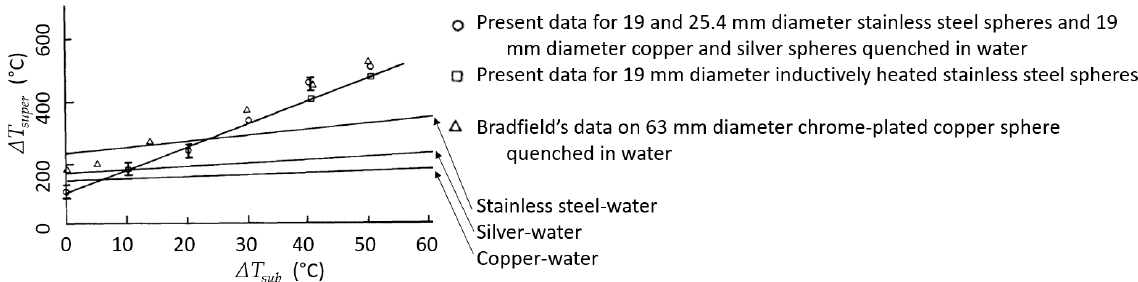
Figure 15. Minimum film boiling temperature for a combination of coolant subcooling ( ∆ T sub , X-axis) and hot sphere superheating ( ∆ T super , Y-axis): experimental (data points connected by a single line) versus theoretical (three separate lines less inclined without data points) (adapted from Reference [83]).